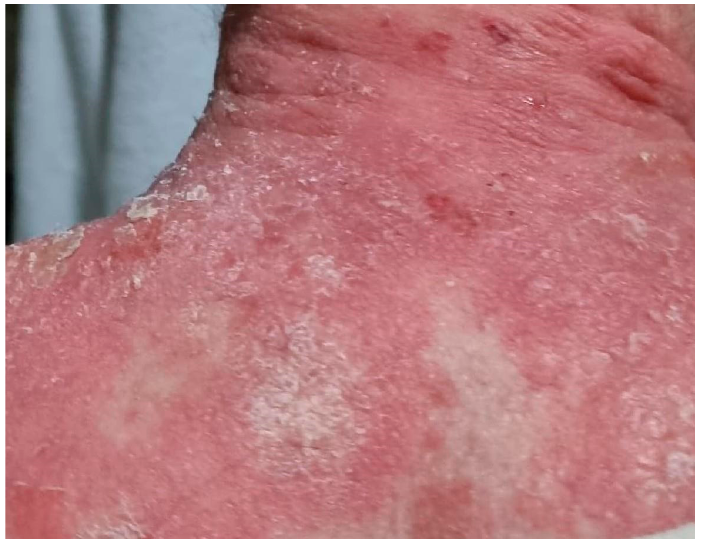
Figure 1. Clinical features of a patient with concurrent psoriasis and bullous pemphigoid, showing erosive lesions in the context of psoriatic plaques.